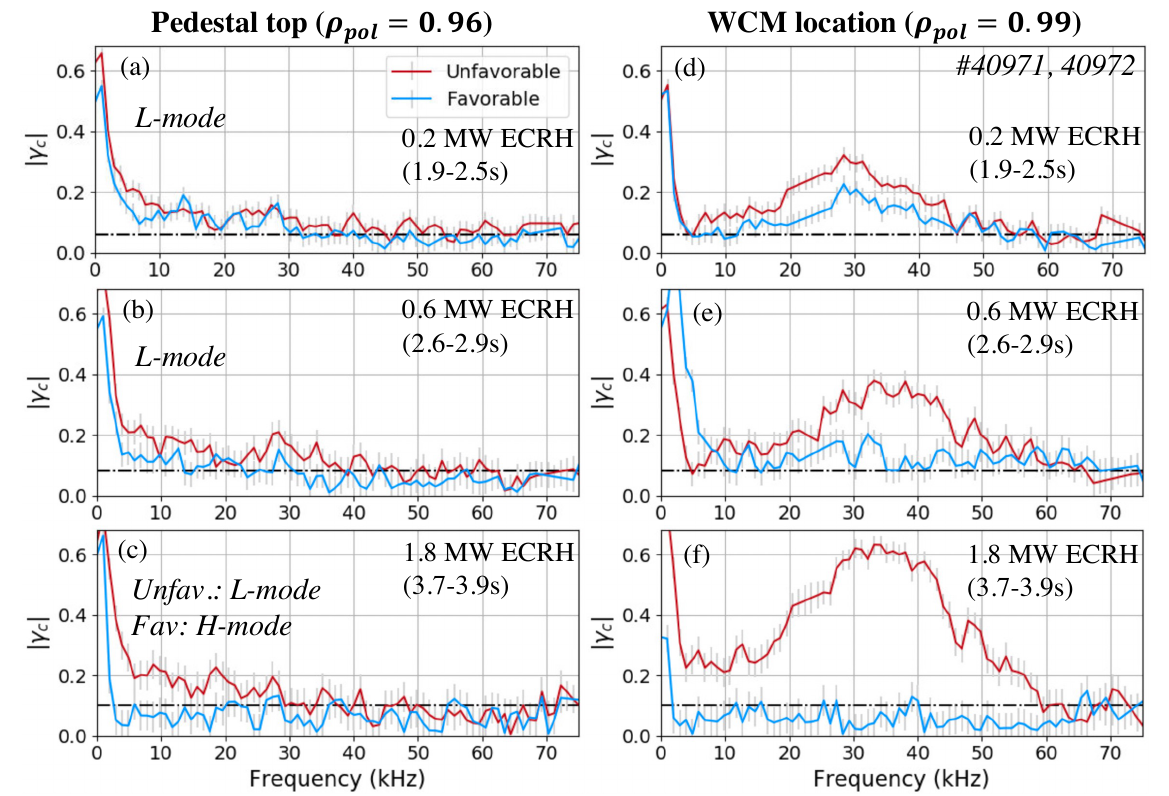
Figure 4. CECE coherency spectra in matched favorable (blue, 40972) and unfavorable (red, 40971) configuration discharge phases. Pedestal top (a-c) and the WCM location (d-f) are shown at three di ff erent ECRH power steps: 0.2 MW (a, d), 0.6 MW (b,e), and 1.8 MW (c,f). The unfavorable configuration plasma remains in L-mode for all power steps while the favorable configuration is in H-mode at the highest power step. WCM formation can be seen in all power steps in unfavorable configuration, and only the lowest power step in favorable configuration.